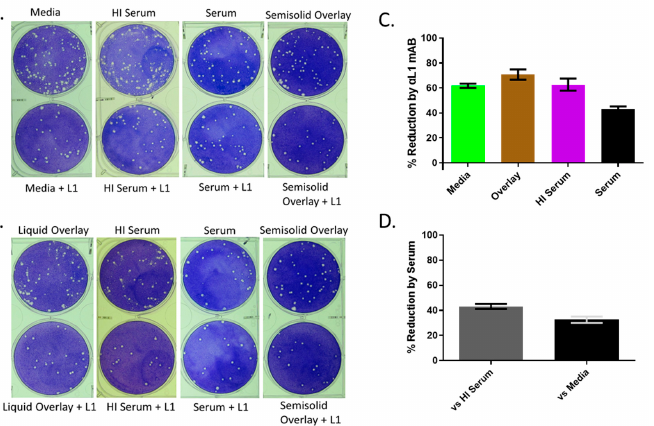
Figure 6. Effect of serum on monkeypox virus comet formation. ( A , B ) Two concentrations of monkeypox virus were adsorbed on Vero E6 cells for 2 h and unattached virus was subsequently removed by washing. A final concentration of 10% cynomolgus serum or heat-inactivated serum in the presence or absence of anti-L1 antibody (1:500) was used to overlay the cells and a 1.5% methylcellulose overlay with and without anti-L1 antibody was utilized as a no-comet control and to determine the effect the antibody on the primary plaques. ( C ) Percent primary plaque reduction in the presence of anti-L1 antibody within each matrix listed on the X axis. ( D ) Percent primary plaque reduction of serum using either the heat-inactivated serum or media to normalize. High virus concentration was a target of 100 pfu/well, whereas intermediate virus concentration was a target of 50 pfu/well.